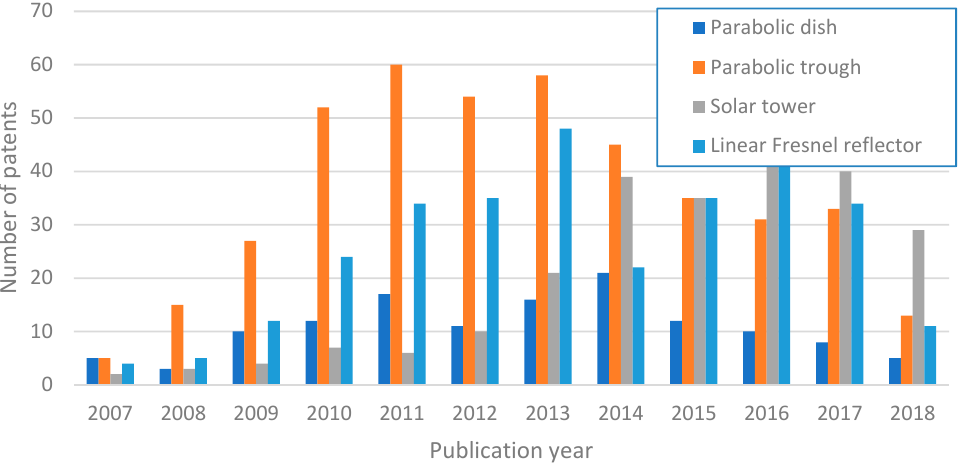
Figure 8. Number of patents vs publication year.